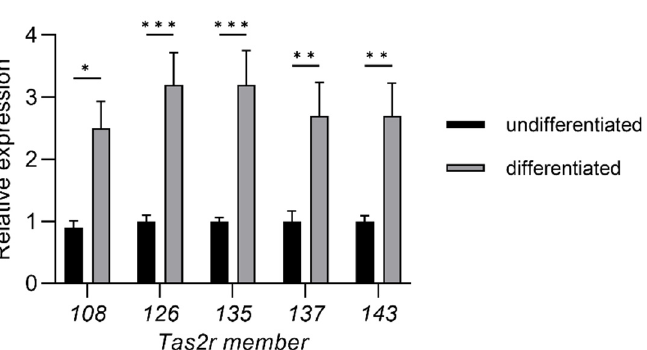
Table 1. Bitter compounds and threshold concentrations for activation of mouse taste 2 receptors (T2Rs) [11].